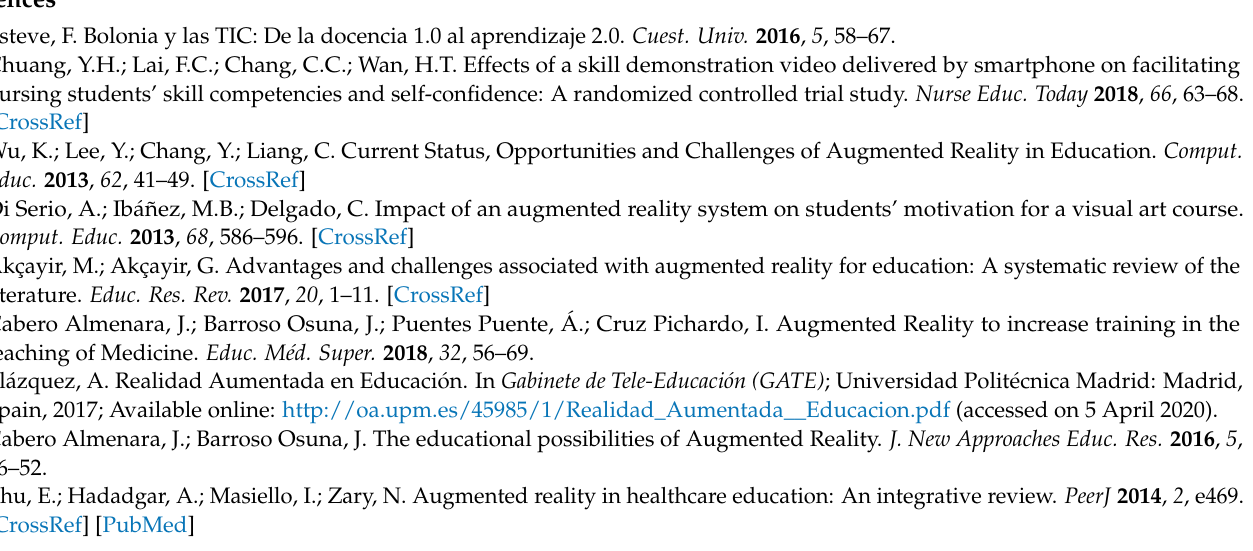
descriptive studies, Table S3: Quality appraisal of quantitative studies (non-randomized: case-control studies), Table S4: Quality appraisal of quantitative studies (randomized controlled trials), Table S5: Quality appraisal of mixed methods